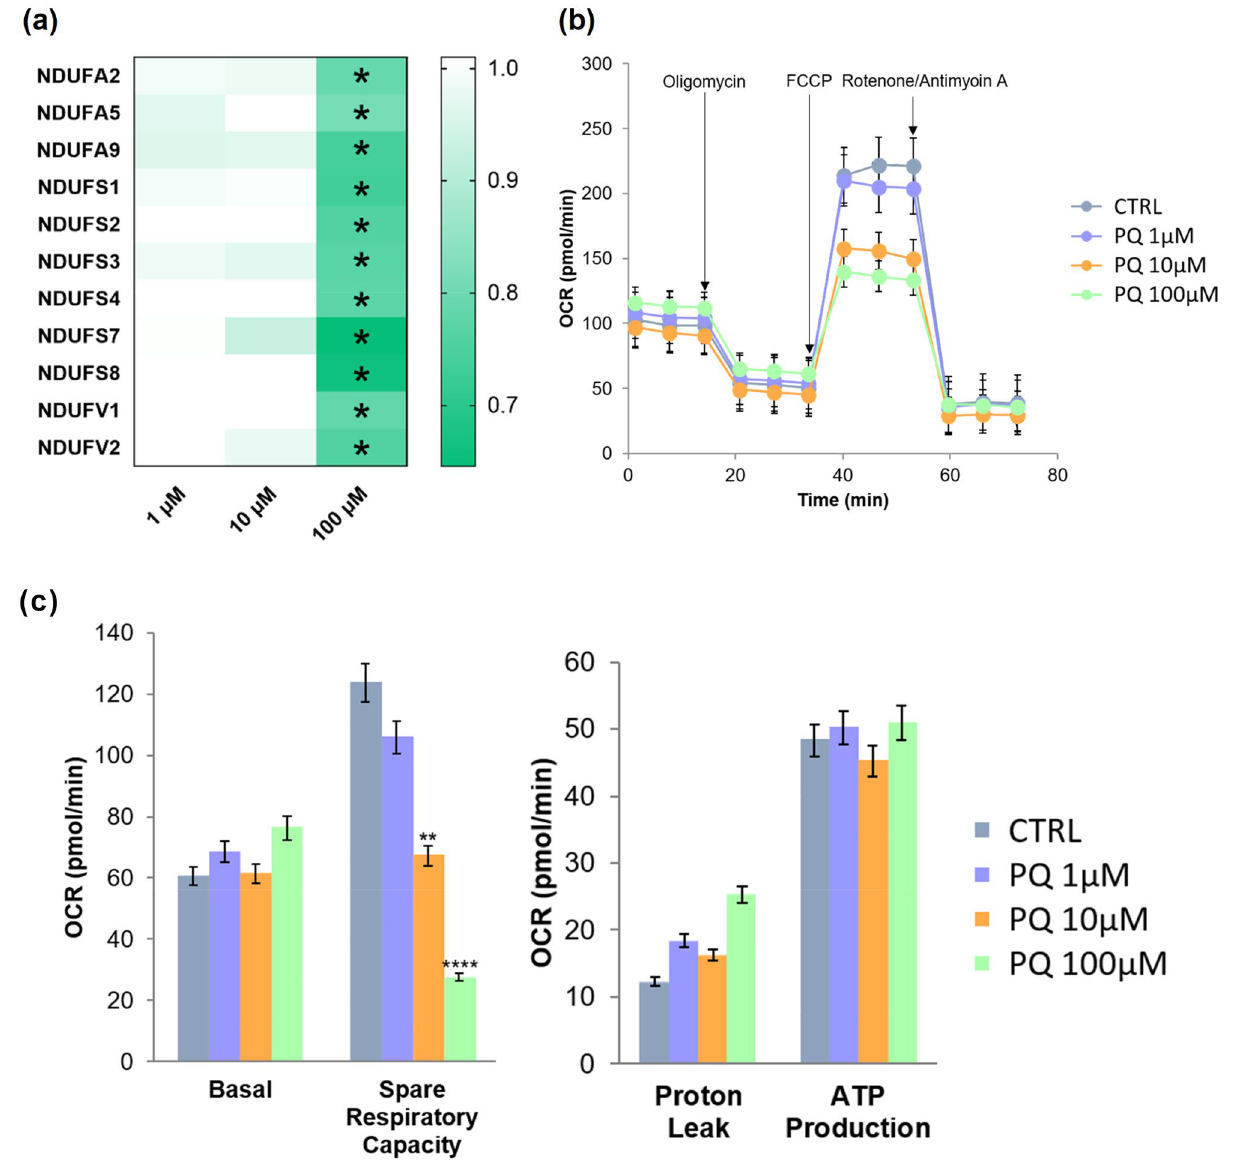
Figure 2. ( a – c ) Mitochondrial dysfunction of PQ-treated HBMECs. ( a ) Heat map of NADH-ubiquinone proteins obtained by MS and altered by PQ exposure. Stars indicate that protein level was modified in HBMECs exposed to PQ for 24 h (LFDR ≤ 0.05; |FC|> 1.2). ( b ) Time-course experiment to assess mitochondrial stress in HBMECs using different PQ concentrations (1, 10 and 100 μM) and control (water). ( c ) Basal respiration, spare respiratory capacity, proton leak and ATP production are represented for each concentration. Data are represented as means ± SD of three biological replicates. ** corresponds to p -value ≤ 0.01 and **** corresponds to p -value ≤